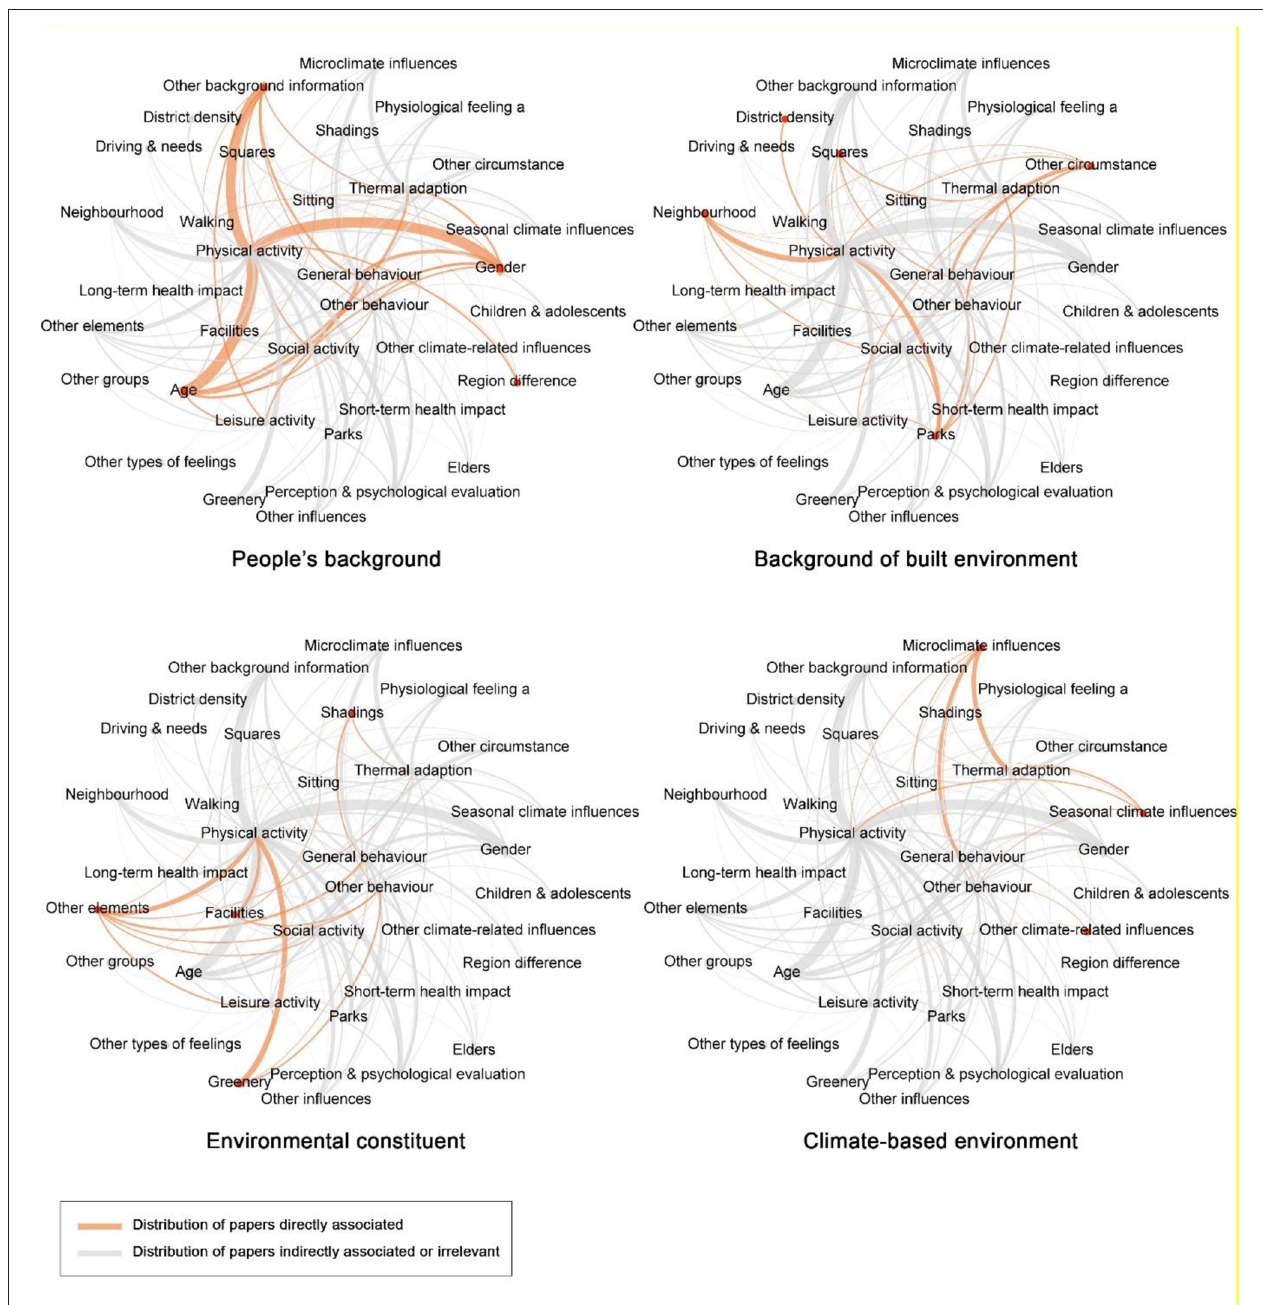
FIGURE 6 | Direct associations related to types of